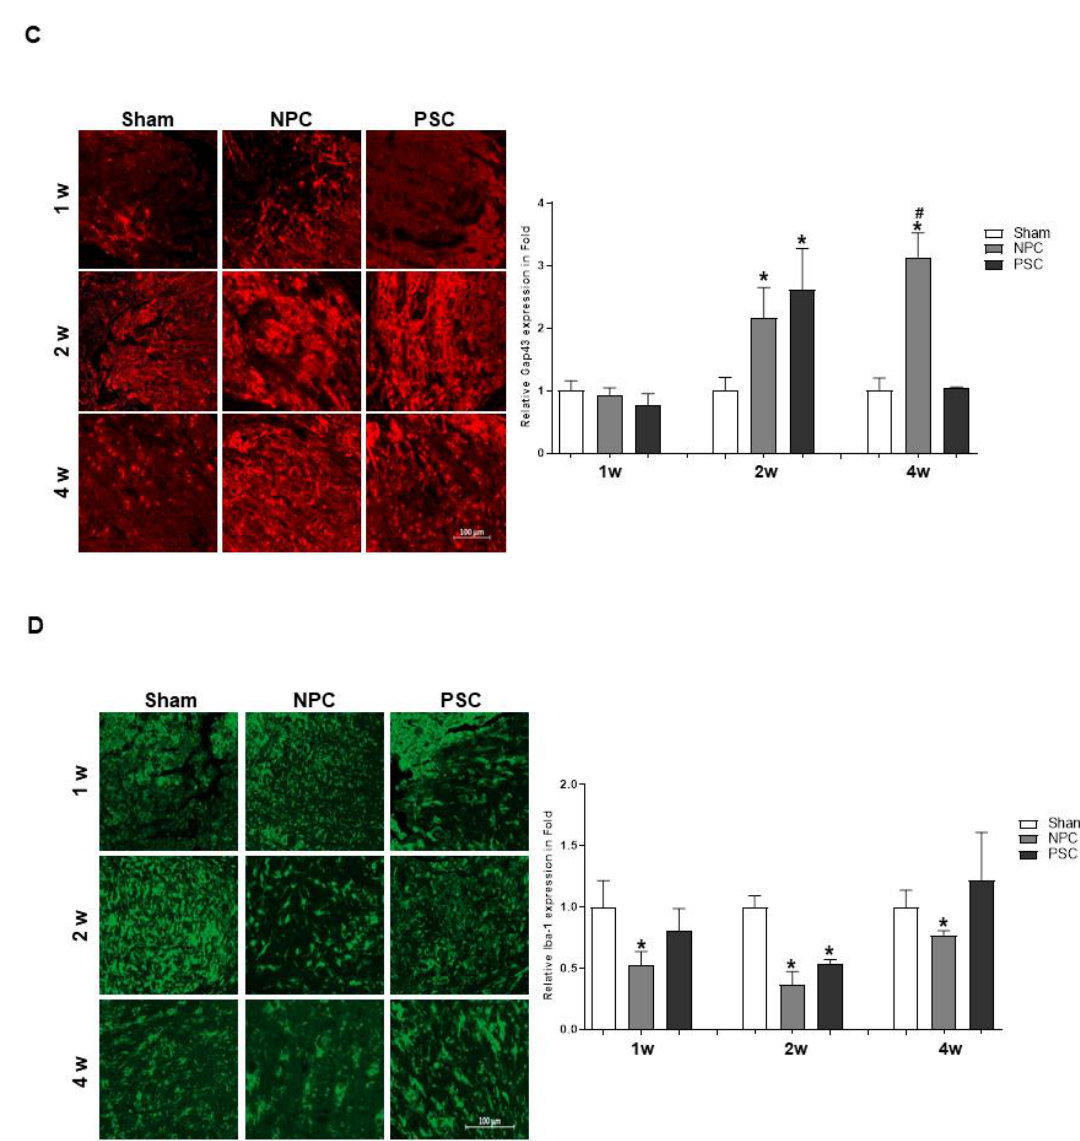
Figure 4. Effects of NPCs promote RGCs and axon regeneration in ONC models. Representative confocal microscopy-based fluorescence images following ( A ) Brn-3a and ( B ) Tuj1 staining (original magnification: 400 × ) of NPCs and hPSCs injection in the optic nerve compression animal model. ( C ) Gap43 and ( D ) Iba1 fluorescence quantification was performed at a 500 µ m distance from the ONC site of the optic nerve. Total GAP43-positive cells were measured using ZEN software. Two retinas and optic nerves from each group were used. The results are presented as the mean ± standard error of the mean (SEM) (* p < 0.05 vs. the age-matched sham (balance salt solution): # p < 0.05 vs. PSCs).